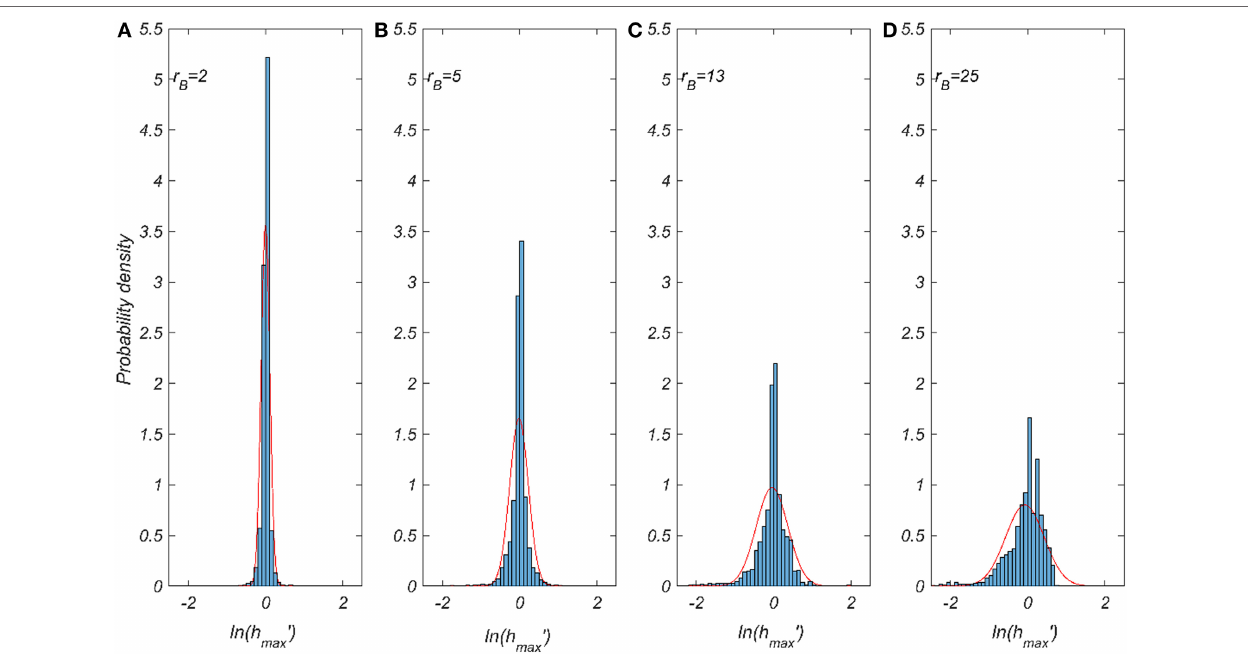
FIGURE 13 | Probability density function (PDF) of normalized h max for 1,000-year event. (A) r B = 2, (B) r B = 5, (C) r B = 13, and (D) r B = 25. Each red line in the panel shows the fitted natural lognormal PDF curves.